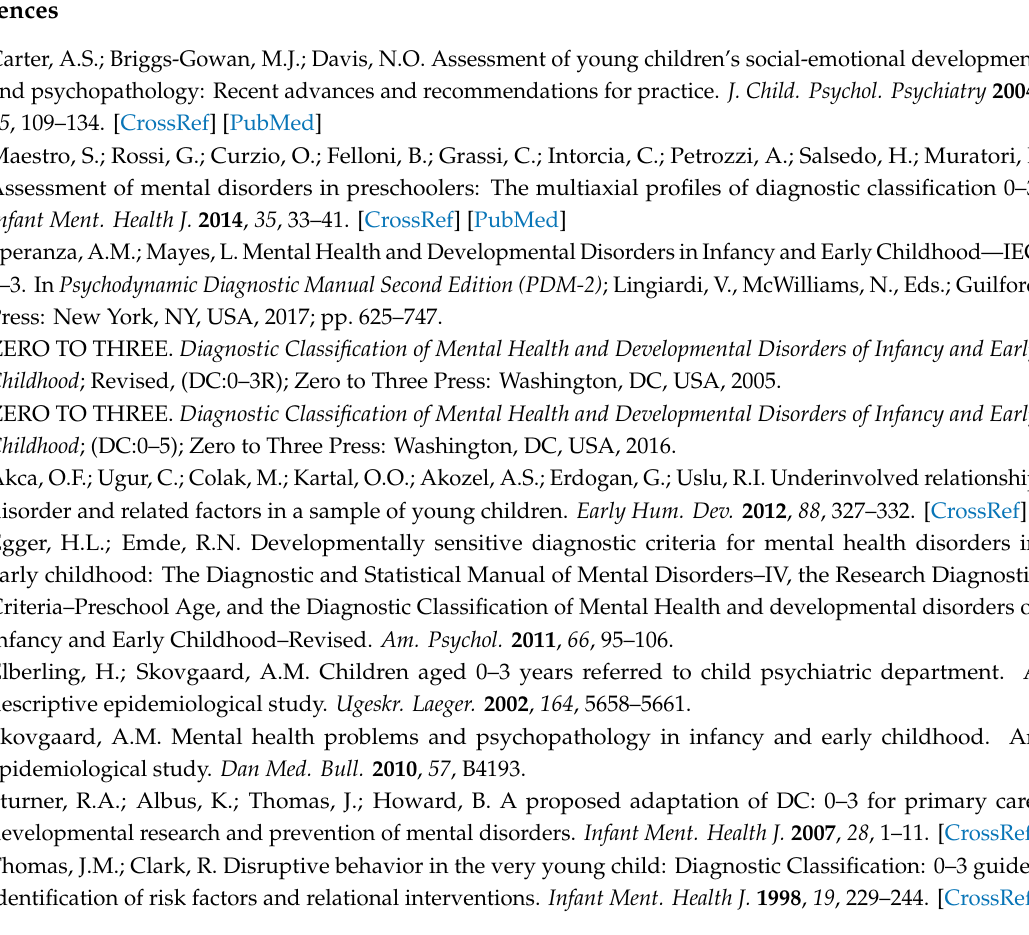
Table S1: Descriptive Statistical Analysis of P-CRS